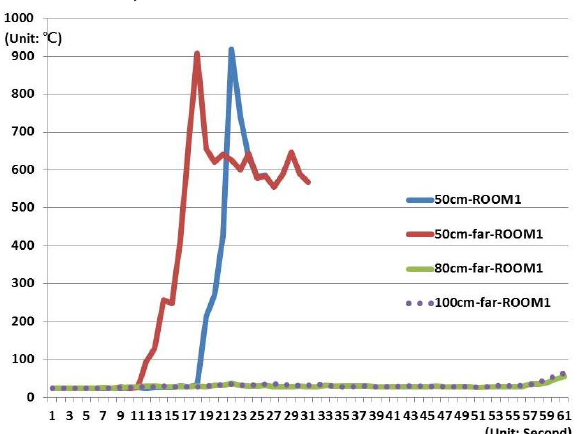
Figure8. Temperature variation occurred in the first room of the left residence.